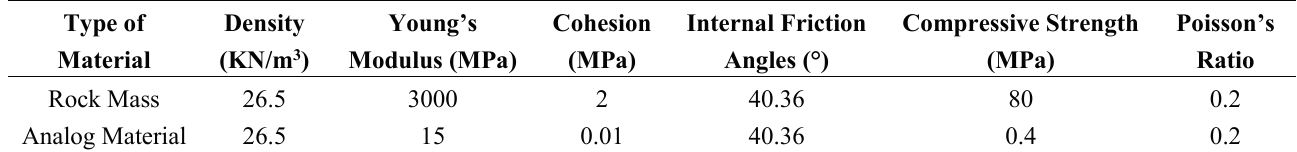
Table 1. The physico-mechanical parameters of the prototype and analogy